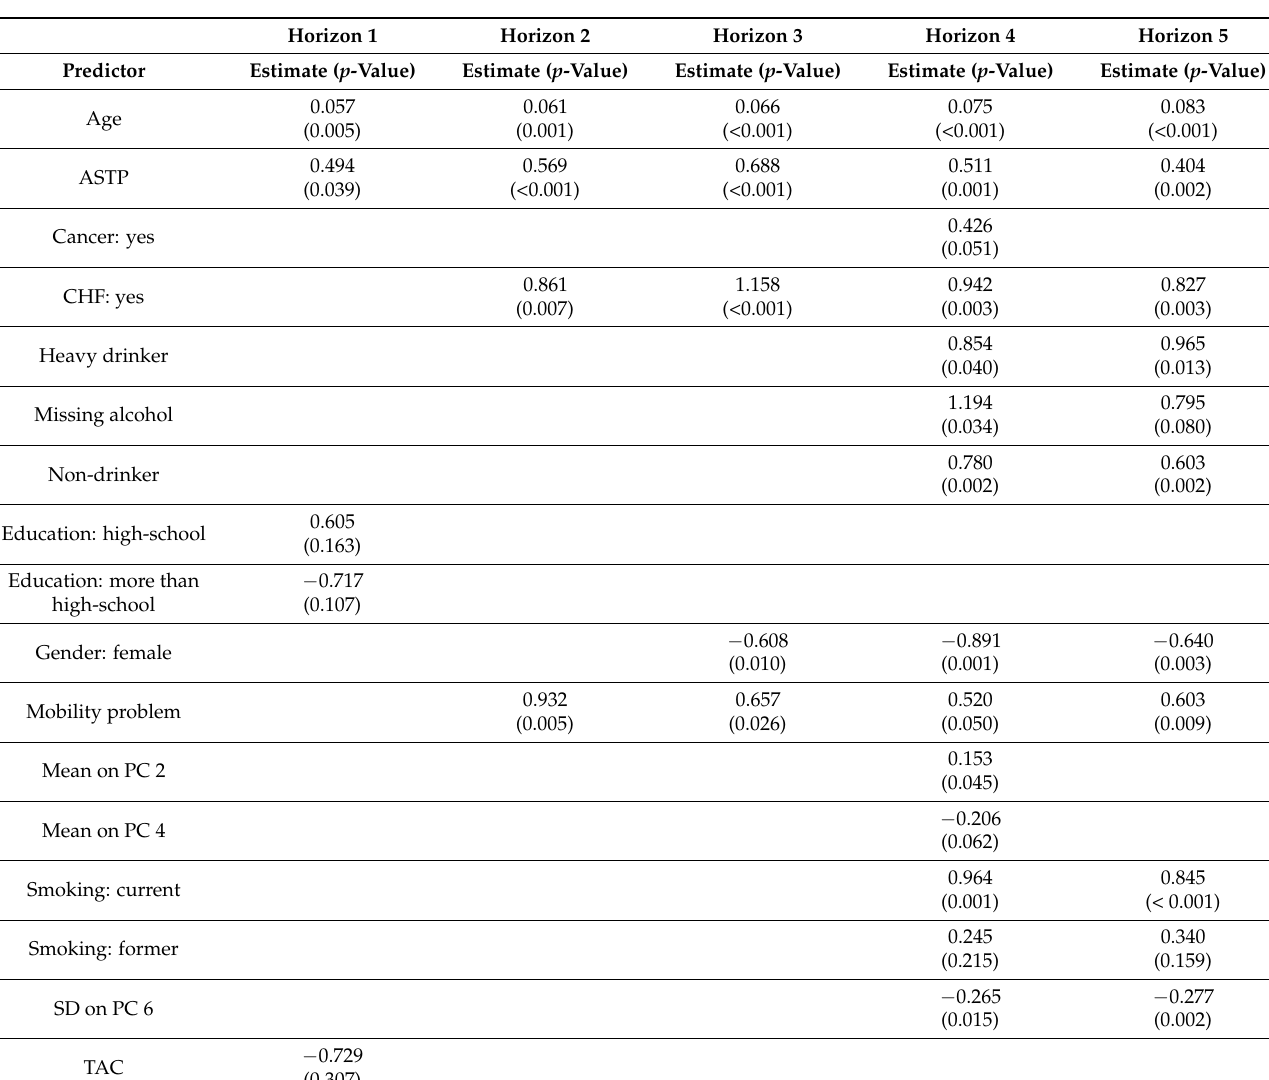
Table 2. Forward regression selection results. Variables that were not selected in the specific horizon prediction model are left